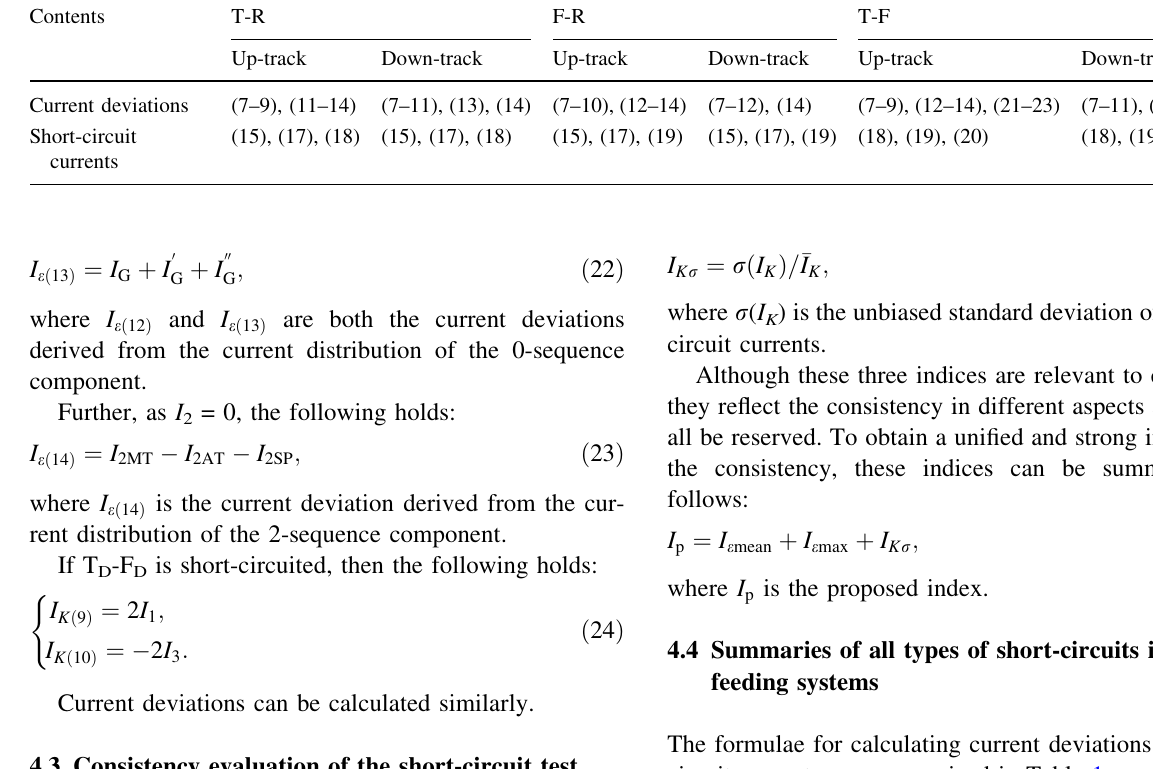
Table 1 Summaries of formulae for calculating current deviations and short-circuit currents for each type of short